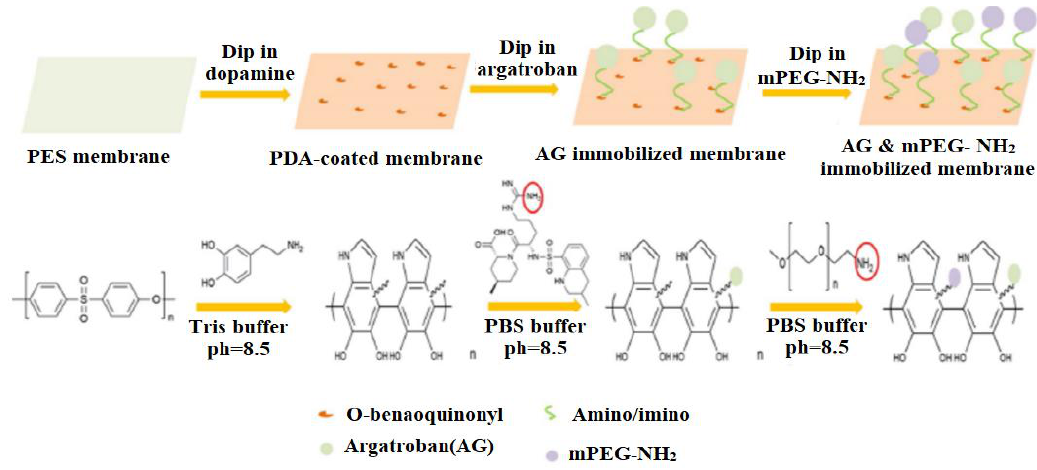
Figure 15. Schematically procedure of PES modification with PDA and AG/mPEG-NH 2 [211].